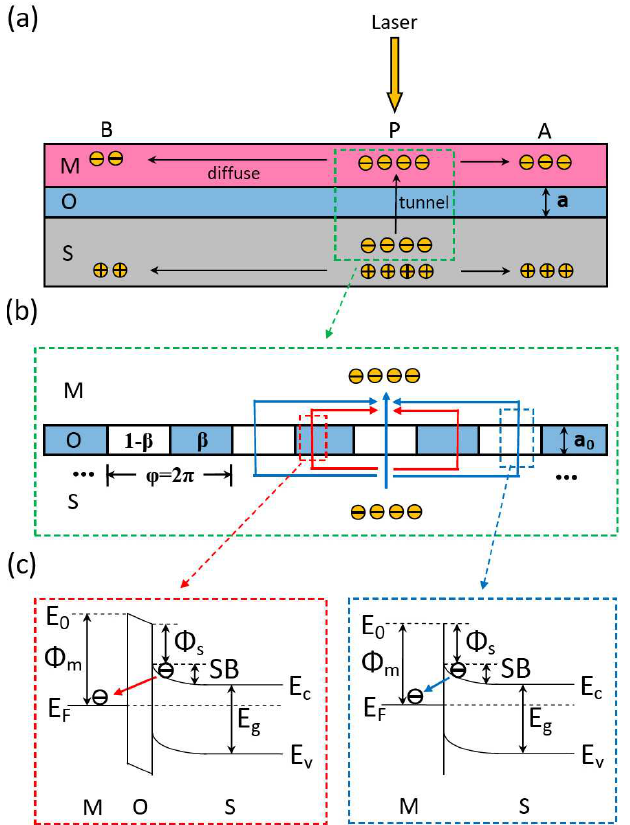
Figure 16. Diagram of oxide thickness effect of LPE in MOS structure. (a) LPE mechanism in MOS structure with a fully covered oxide layer. (b) Electronic interference based on un-fully covered oxide layer when excited electrons transit from semiconductor to metal. The red (or blue) arrows represent the electrons tunneling through the walls (or passing through the windows) from semiconductor to metal. (c) Band models of electrons as tunneling through the walls (red part) and passing through the windows (blue part) from semiconductor to